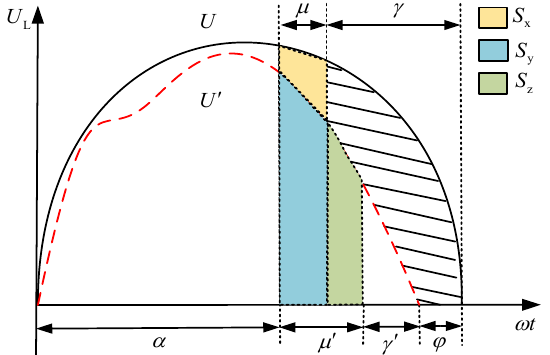
Figure 3. Diagram of voltage waveform distortion.